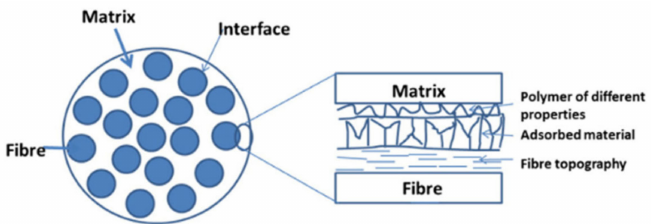
Figure 5. Simple schematic of plant fiber/matrix interface. Reproduced with permission from [43]. Copyright 2015